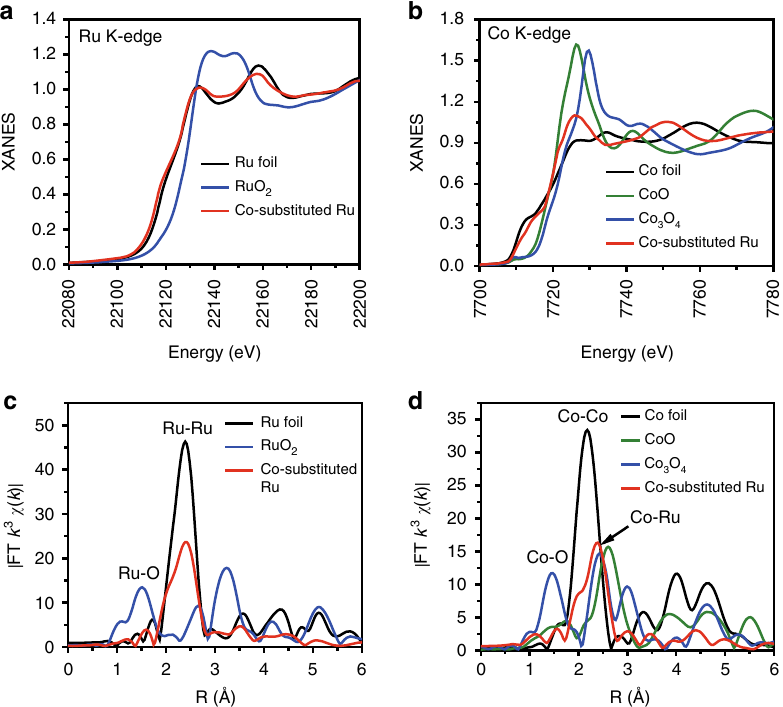
Fig. 2 Structure determination of Co-substituted Ru by XAFS. XANES spectra of Co-substituted Ru for a Ru K-edge and b Co K-edge. Fourier transformed (FT) k 3 -weighted χ ( k )-function of the EXAFS spectra for c Ru K-edge and d Co